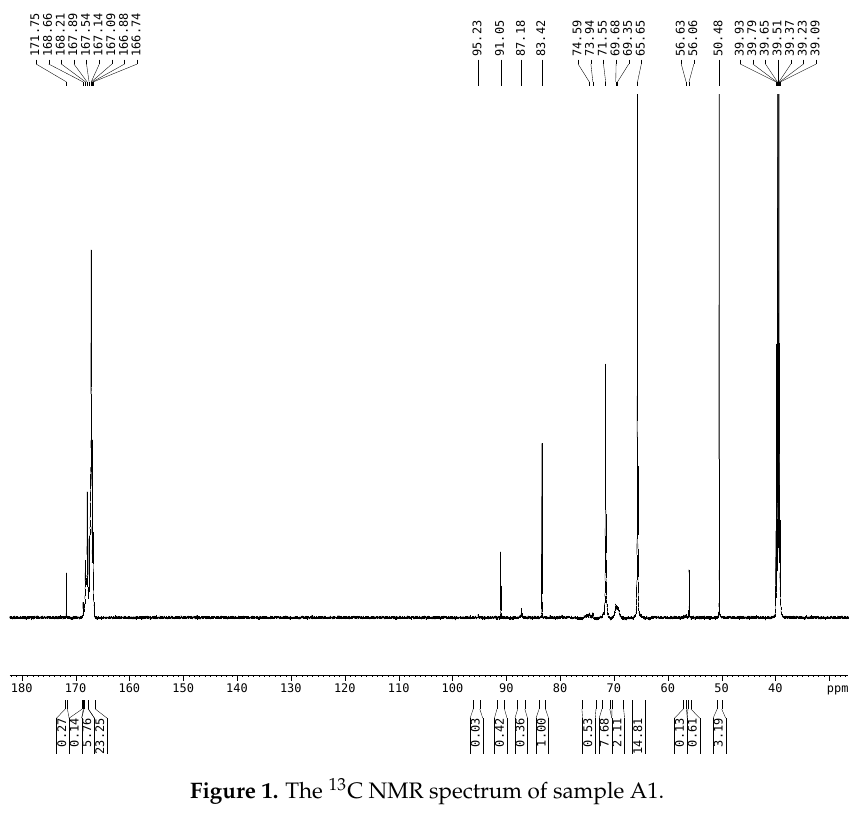
150.9194083 MHz